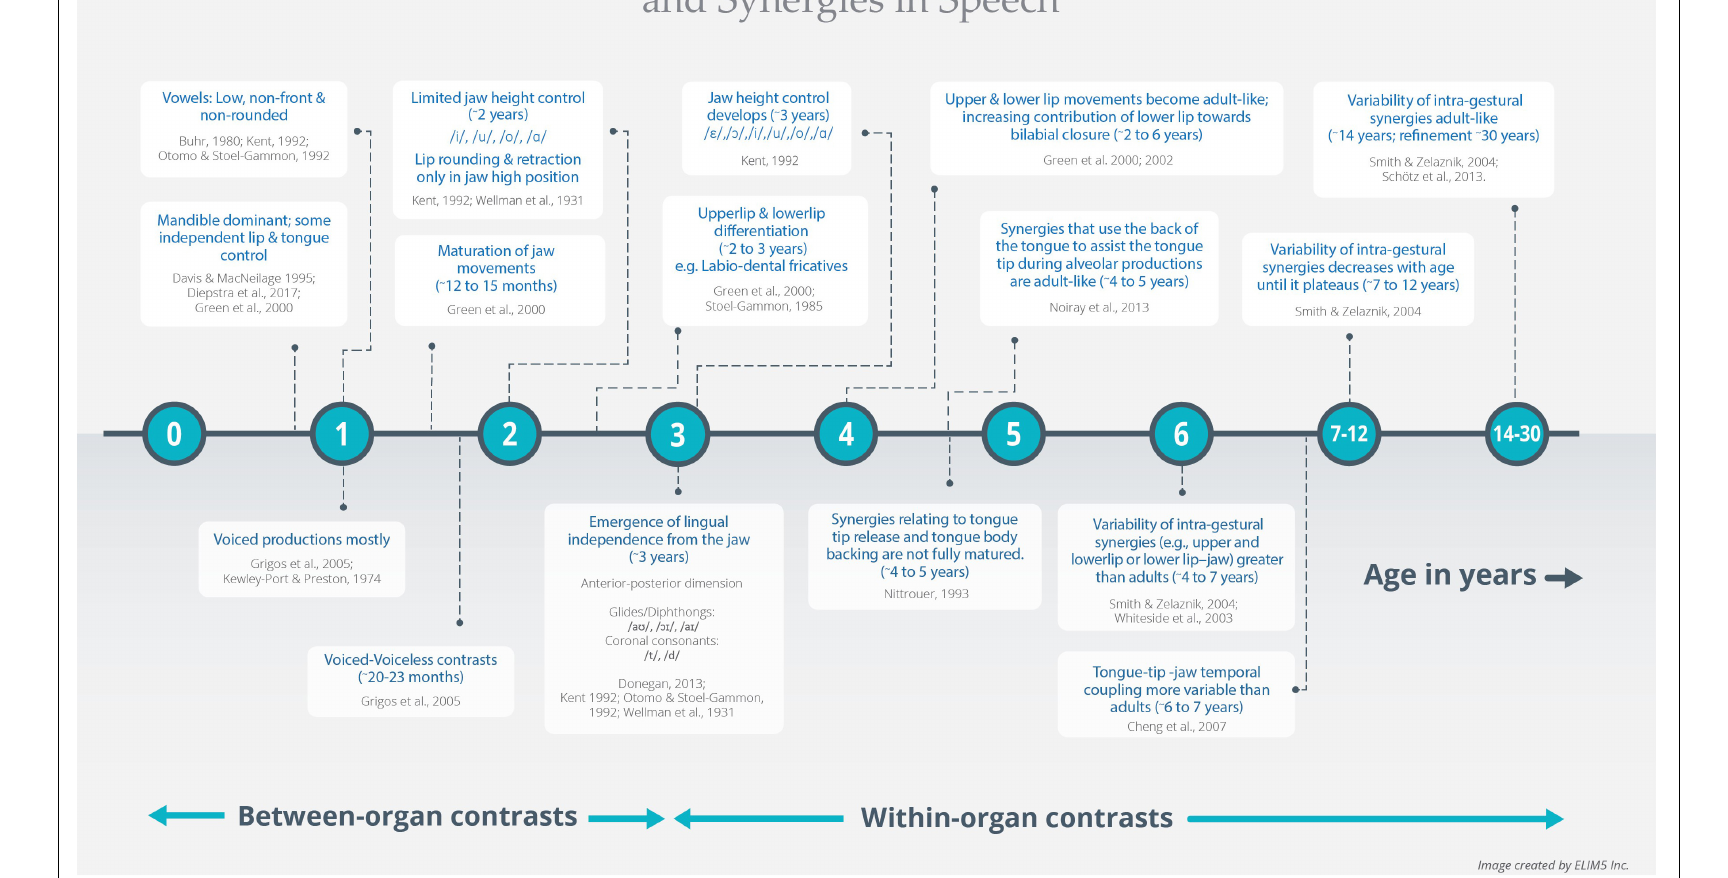
FIGURE 1 | Data driven timeline map of the development of speech motor control and articulatory